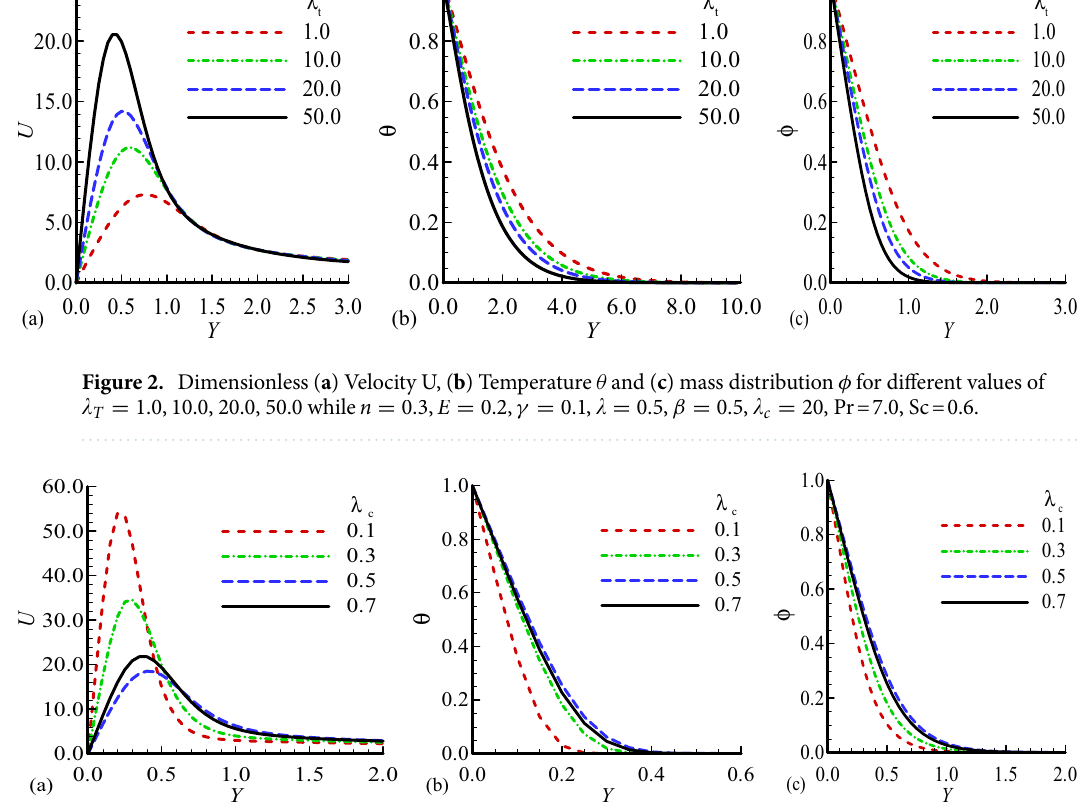
Figure 3. Dimensionless ( a ) Velocity U , ( b ) temperature θ and ( c ) mass distribution φ for different values of (cid:31) c = 0.1, 0.3, 0.5, 0.7 while n = 0.3 , E = 0.2 , γ = 0.1 , (cid:31) = 0.5 , β = 0.5 , (cid:31) T = 20 , Pr = 7.0, Sc =